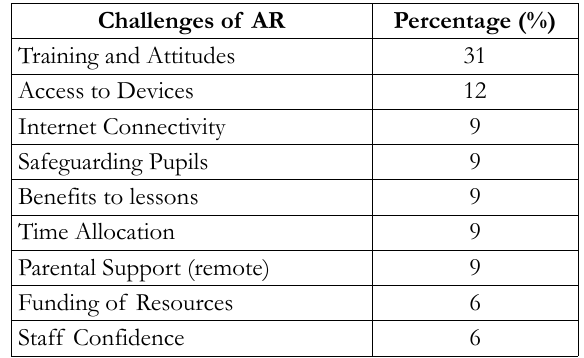
Table 16. Percentage of teacher references for AR challenges. (Contextual